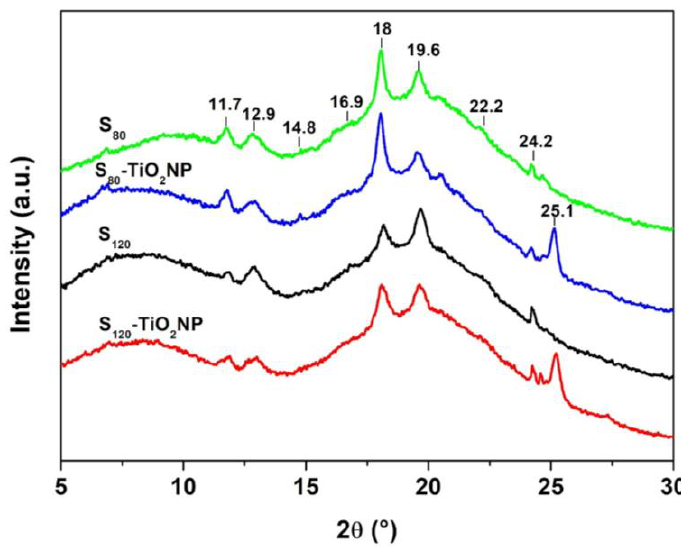
Figure 4. X-ray diffraction patterns of S 80 , S 80 -TiO 2 NP, S 120 , and S 120 -TiO 2 NP. Relevant changes in X-ray pattern and relative crystallinity (RC) of the films were